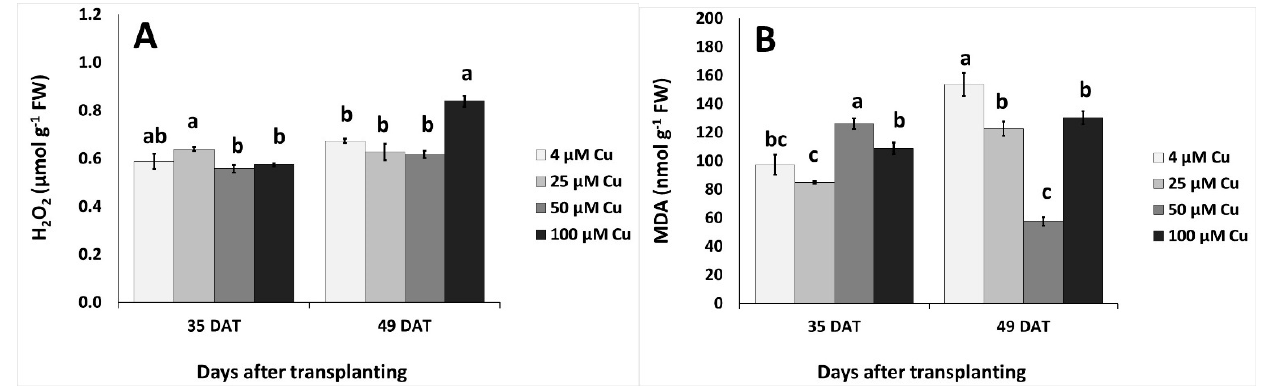
Figure 3. Effect of increasing copper (Cu) concentration (4–25–50–100 µ M Cu 2+ ) in the nutrient solution and sampling date after transplanting (DAT, 35 days and 49 days) on the leaf content of hydrogen peroxide (H 2 O 2 ; ( A )) and malondialdehyde (MDA; ( B )) in pelargonium plants grown hydroponically in perlite. Significant differences ( p < 0.05) among Cu concentrations at each sampling date are indicated by different letters. Error bars show SE ( n = 4).